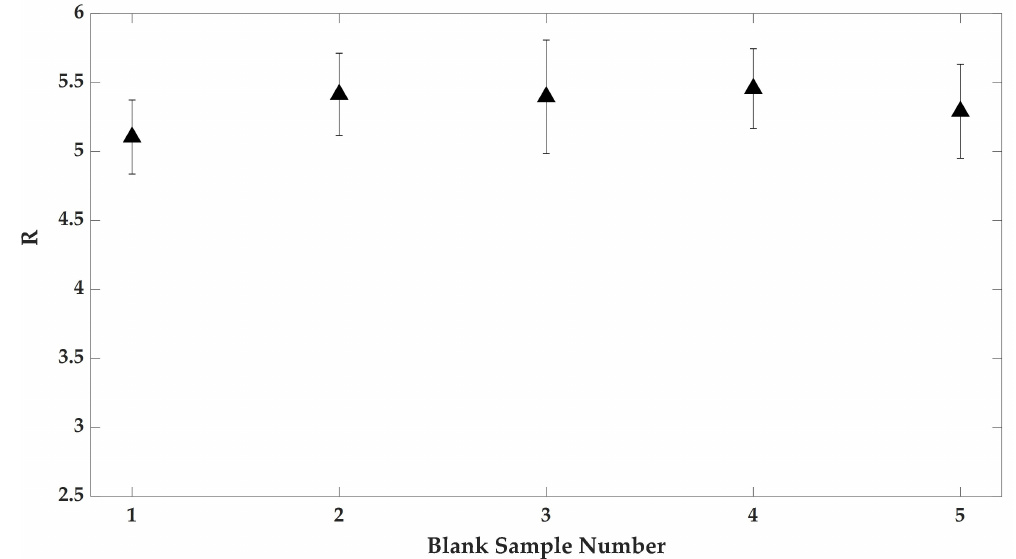
Figure 7. Raman intensities ratio I 2930 / I 2845 calculated in five blank samples collected from the volunteer not wearing